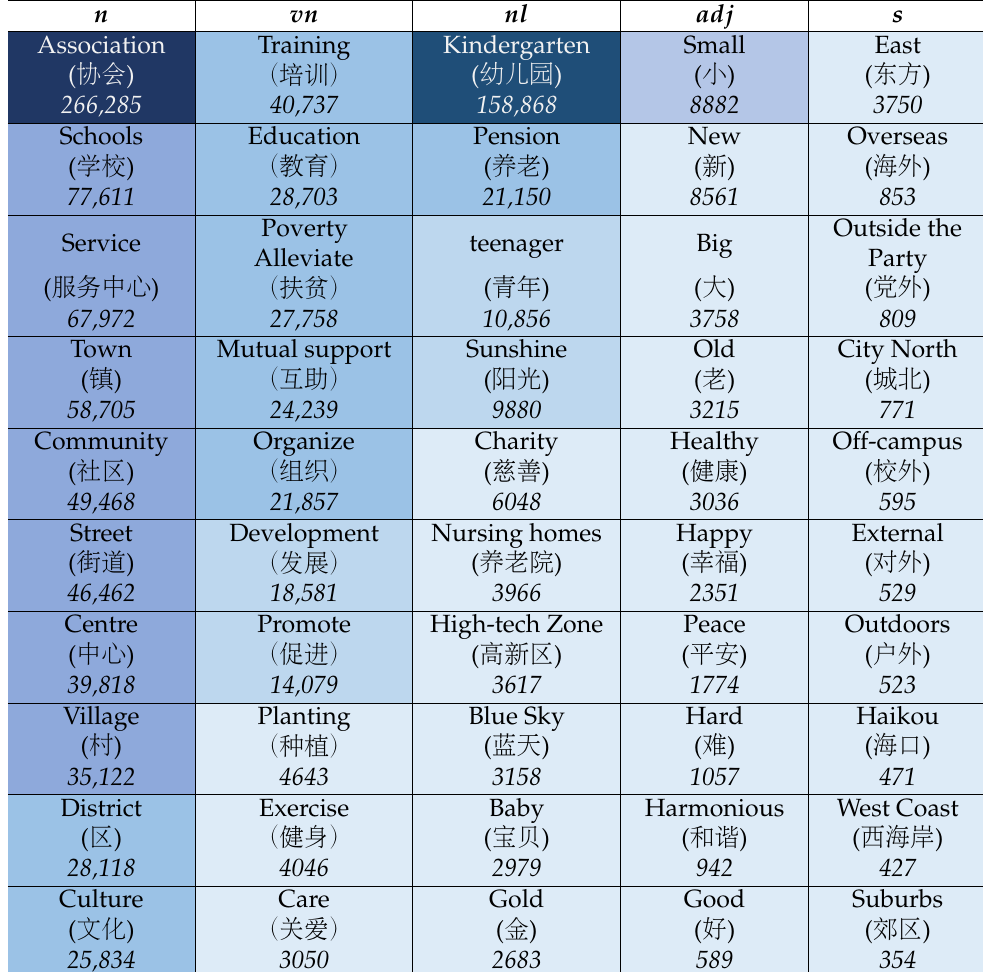
Table 3. Top 10 popular keywords ranked by the occurrence